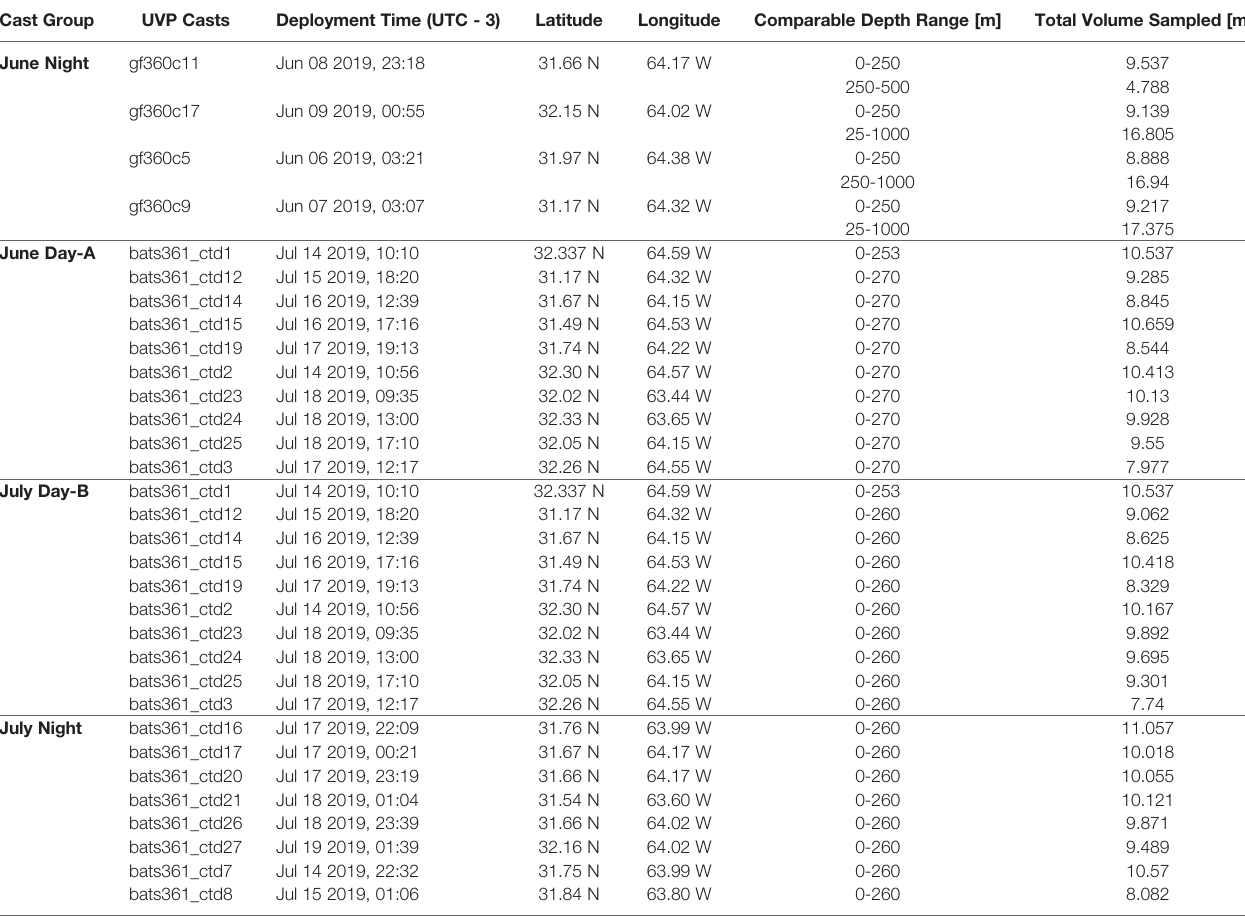
TABLE 1 | Metadata for UVP